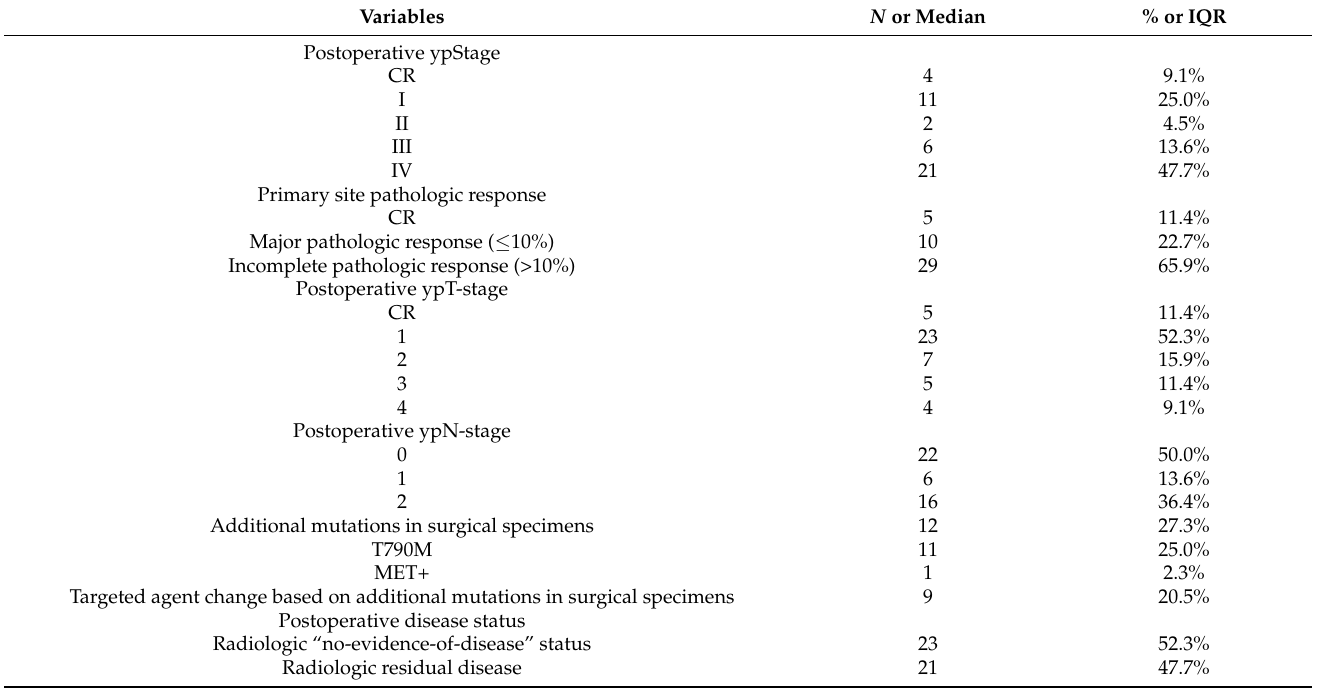
Table 4. Pathology and postoperative disease